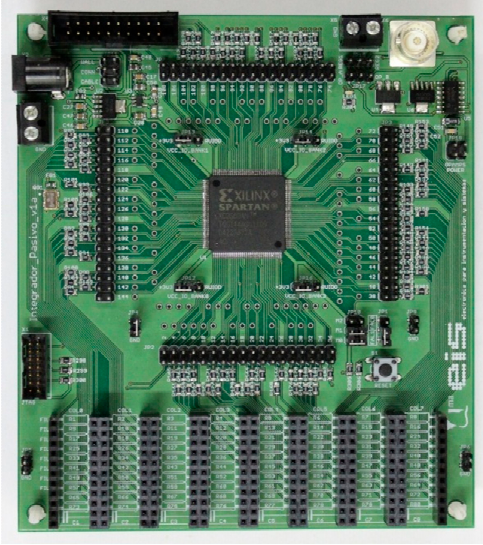
Figure 4. Setup to test the direct interface circuit for resistive sensor array.